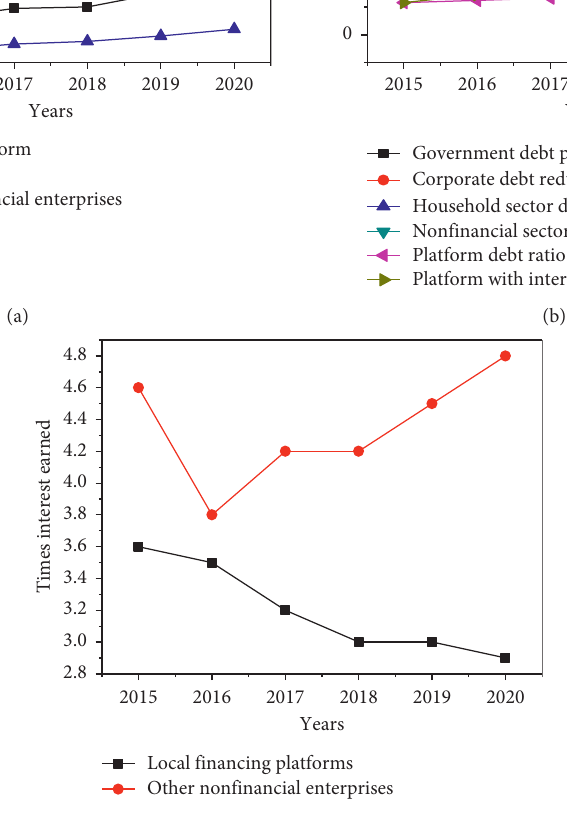
Figure 3: Bond-issuing enterprises cumulative debt increase, return on equity, and multiple interest